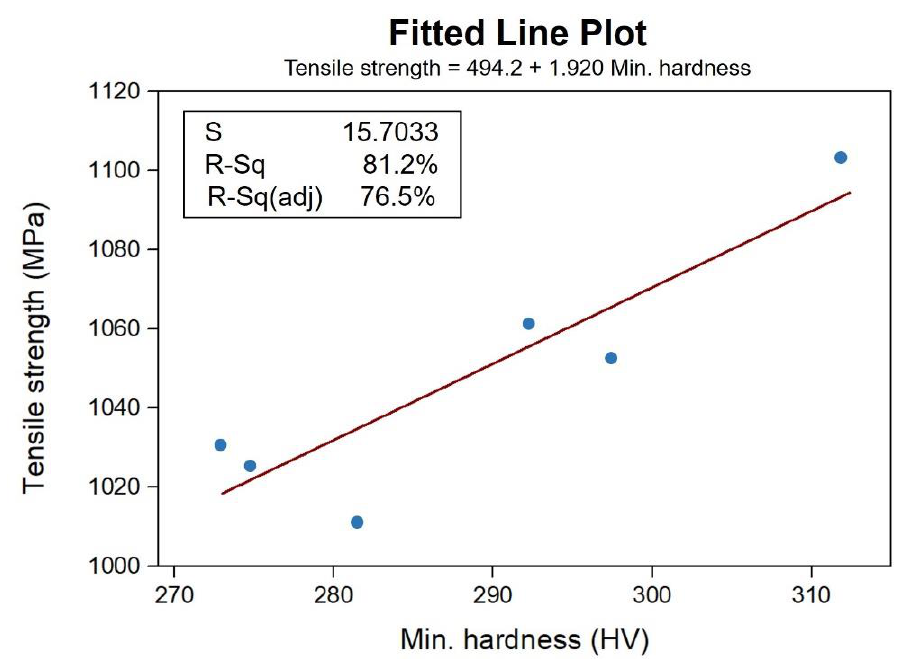
Figure 17. Relation between tensile strength and min hardness results of GMAW.